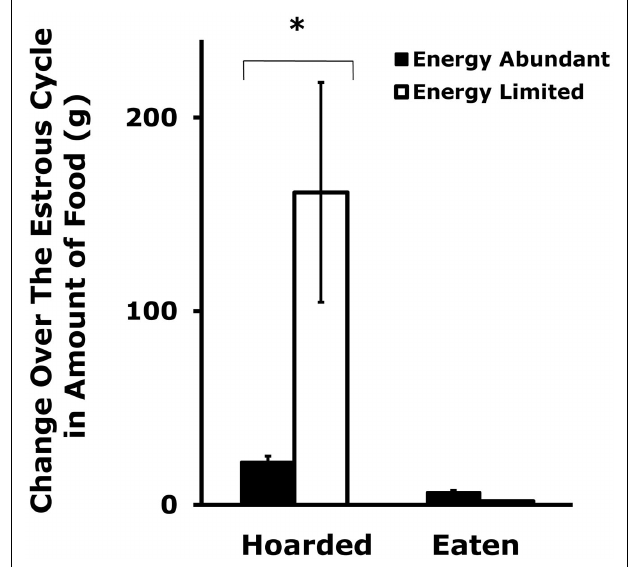
FIGURE 3 | Mean and SE of the change in food hoarding that is seen over the estrous cycle in food-limited female Syrian hamsters compared to those with unlimited food. * = significantly different from females with unlimited food. After Klingerman et al.